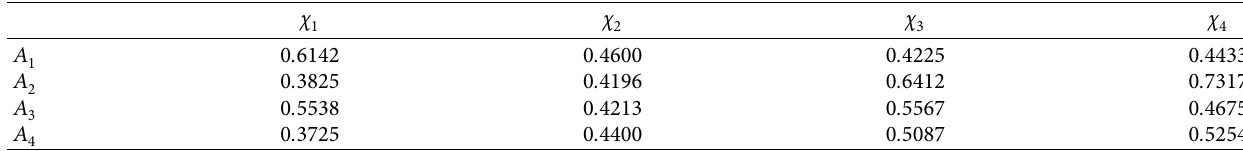
Table 15: Score values of expert